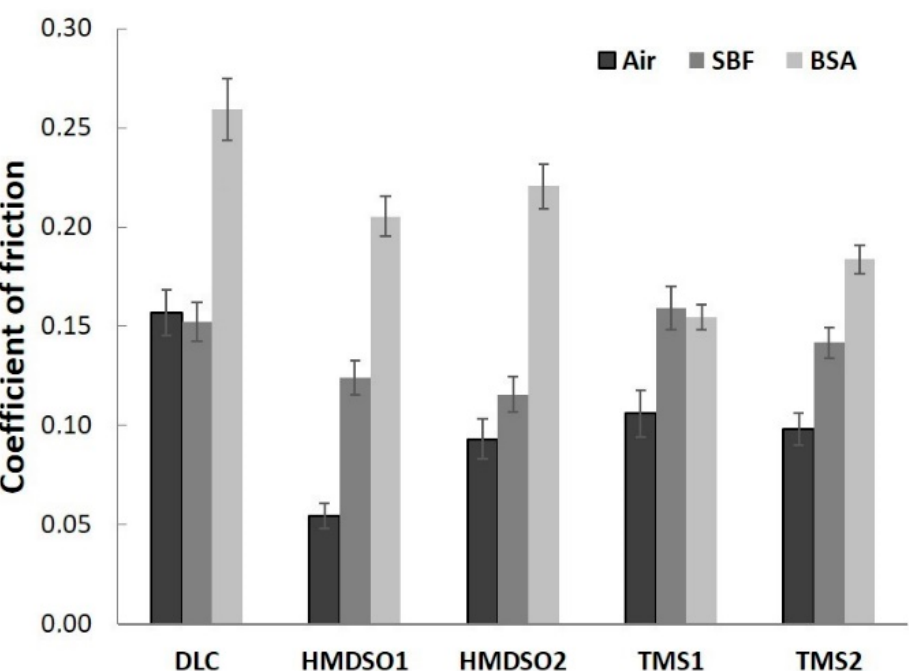
Figure 1. Comparison of the friction coefficient of silicon-incorporated DLC coatings in different environments: air, SBF, and BSA.